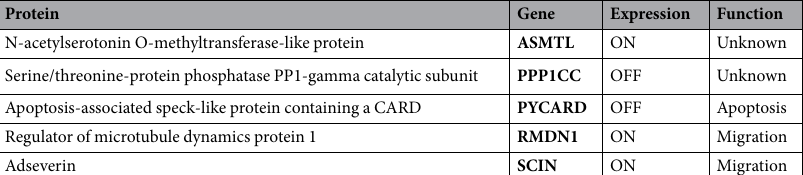
Table 3. Targets detected in just one of the groups: M1 and M2 and M3 OR MCF7 and